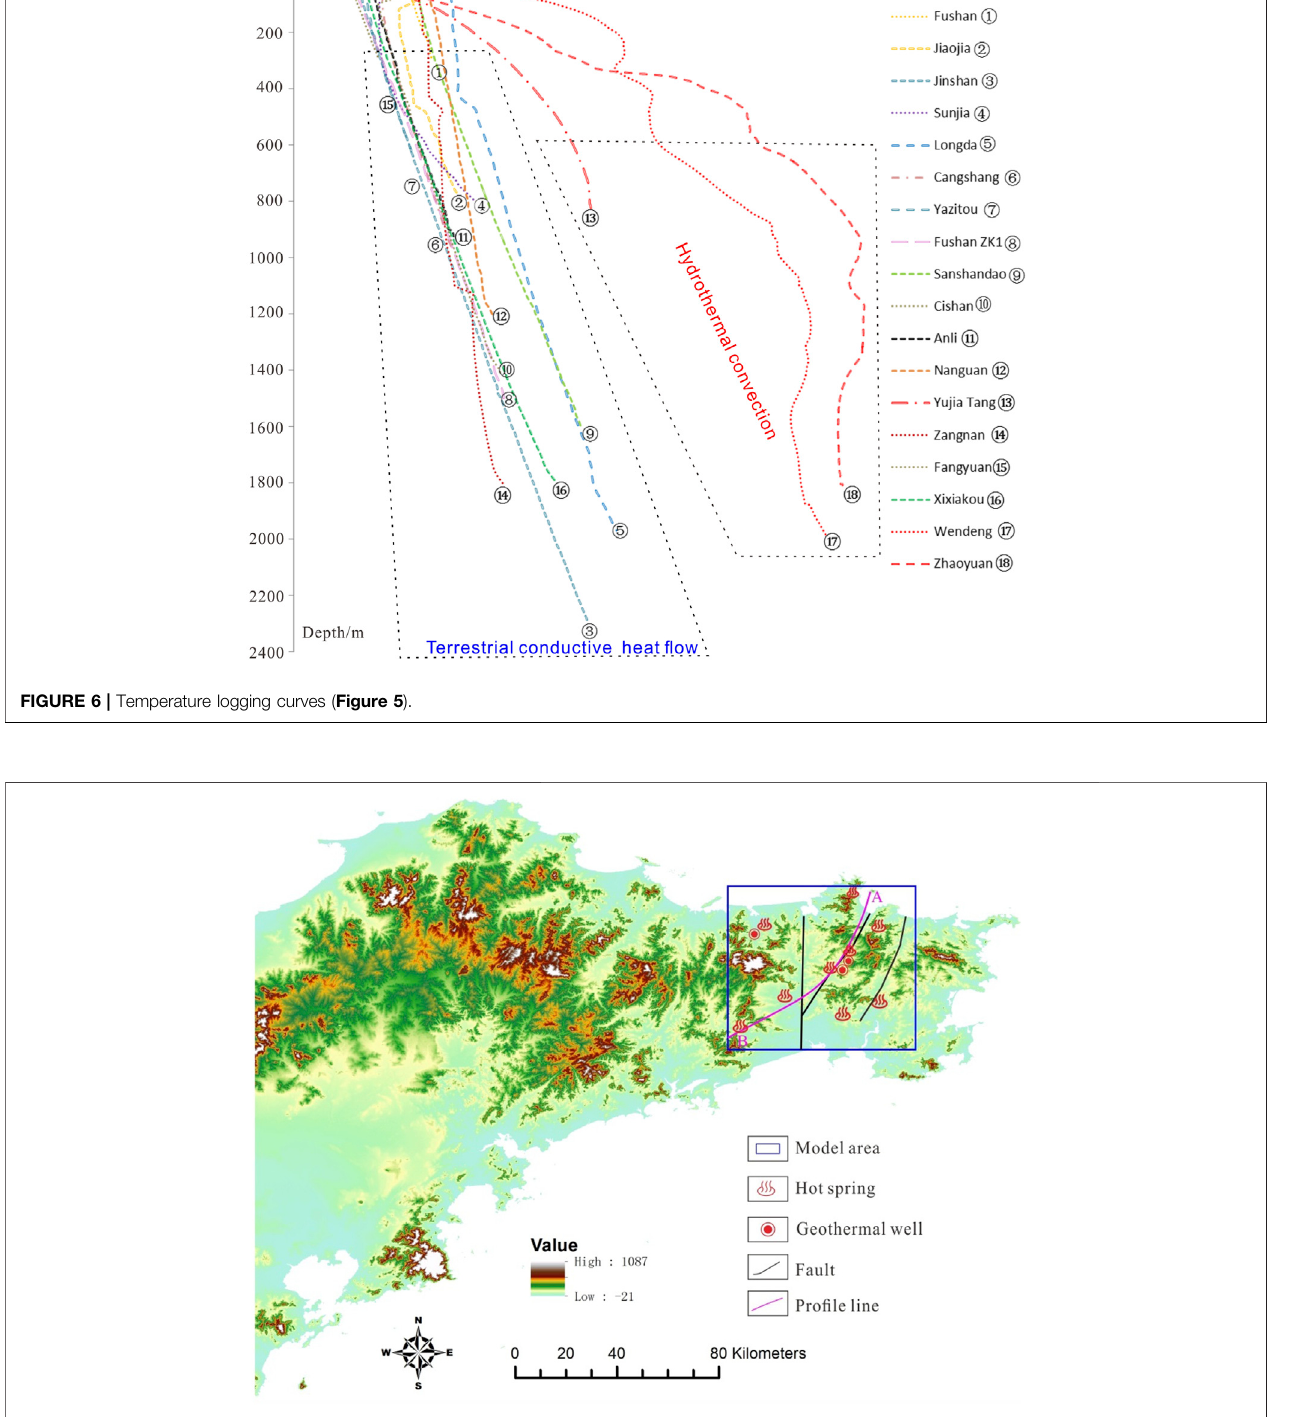
Frontiers in Earth Science |